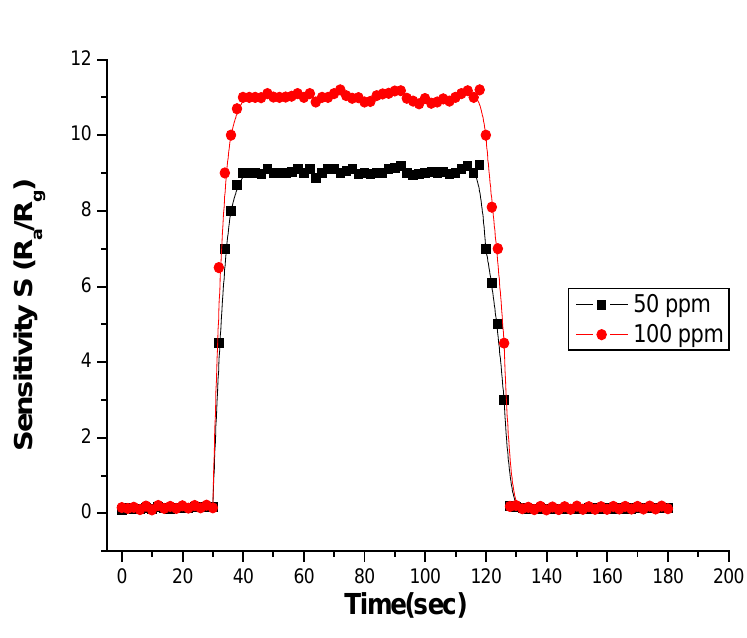
Figure 7. The response transients of sensors to 50 ppm and 100 ppm CO gas at the working temperature 200 o